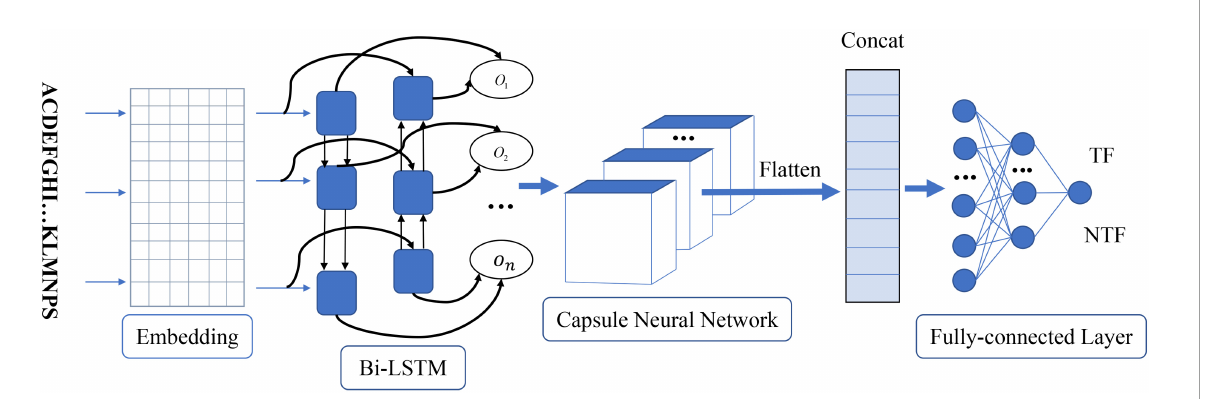
FIGURE1 The architecture of the proposed capsule network-based method. O n represents the word vector after the bidirectional LSTM layer. TF and NTF represent the final predicted outcome as a transcription factor or not.